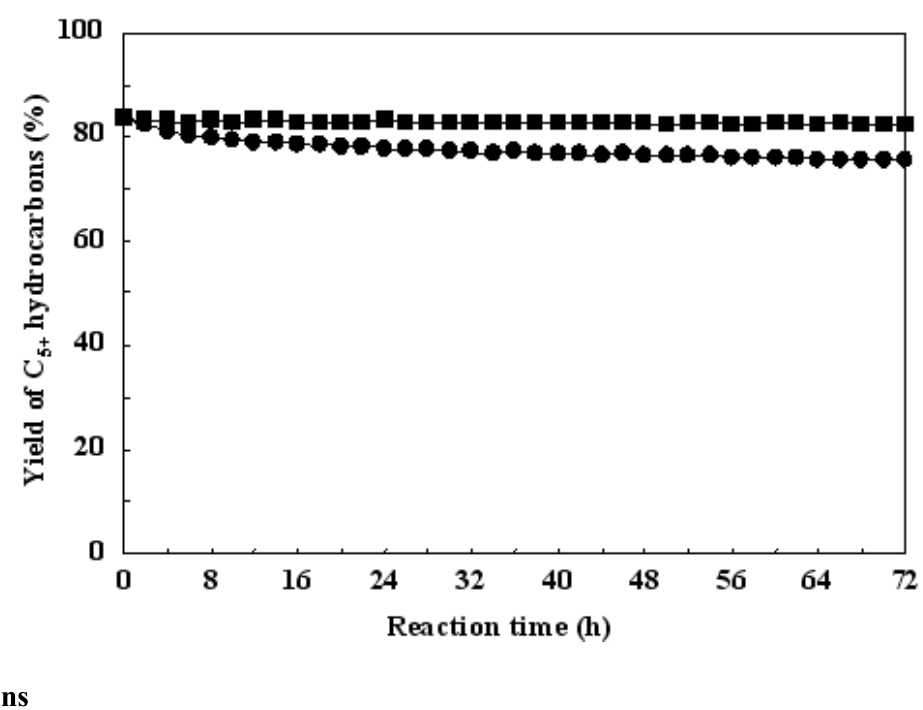
Figure 9. Time sequences in the hydrotreatment of waste cooking oil containing 10 ppm -Mont ( ● ) and sulfided Ni-Mo/Al DMDS over Ru/Al 13 same as those in Table